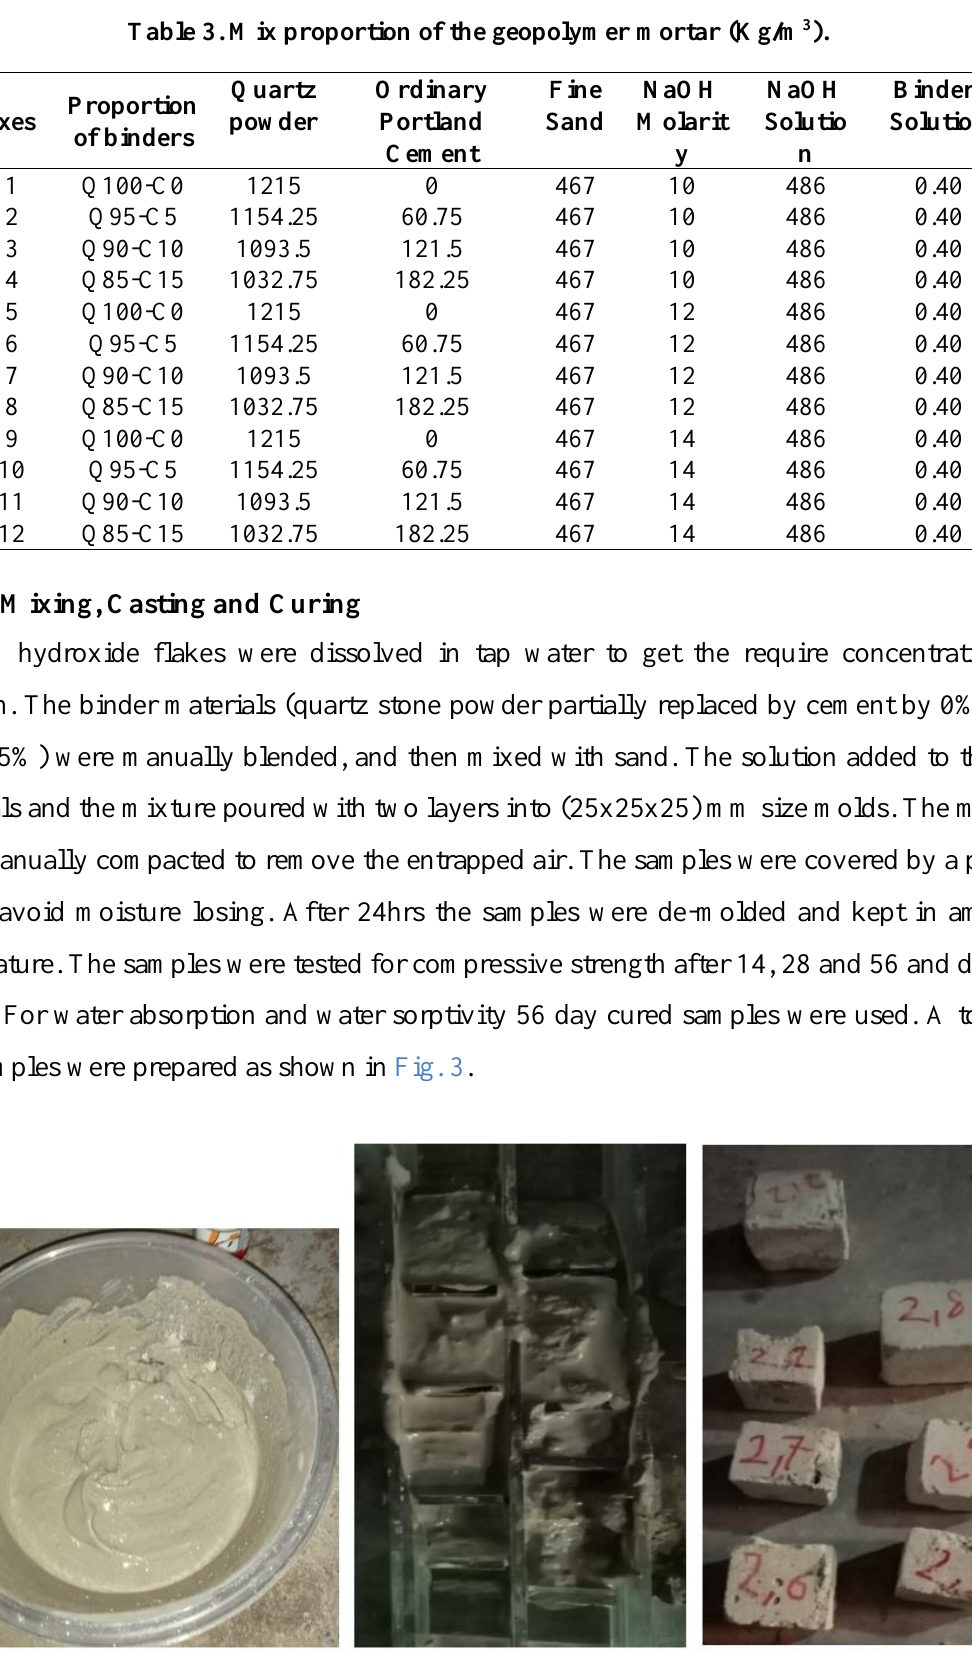
Fig. 3. Mixing, casting, and ambient curing of geopolymer mortar